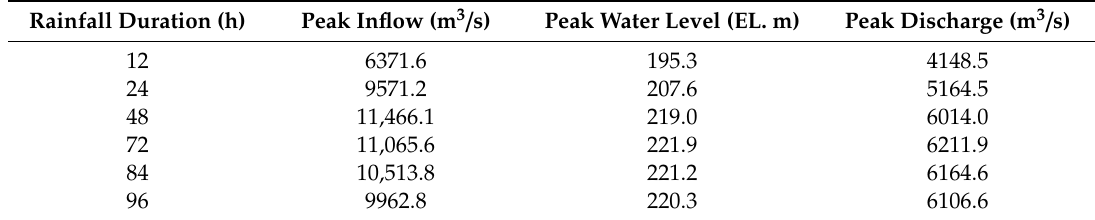
Table 3. Simulation results of peak water level and peak discharge of the Peace Dam depending on the rainfall duration.